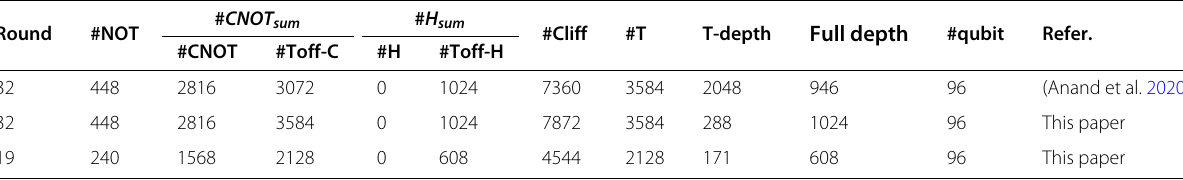
Table 4 Cost of